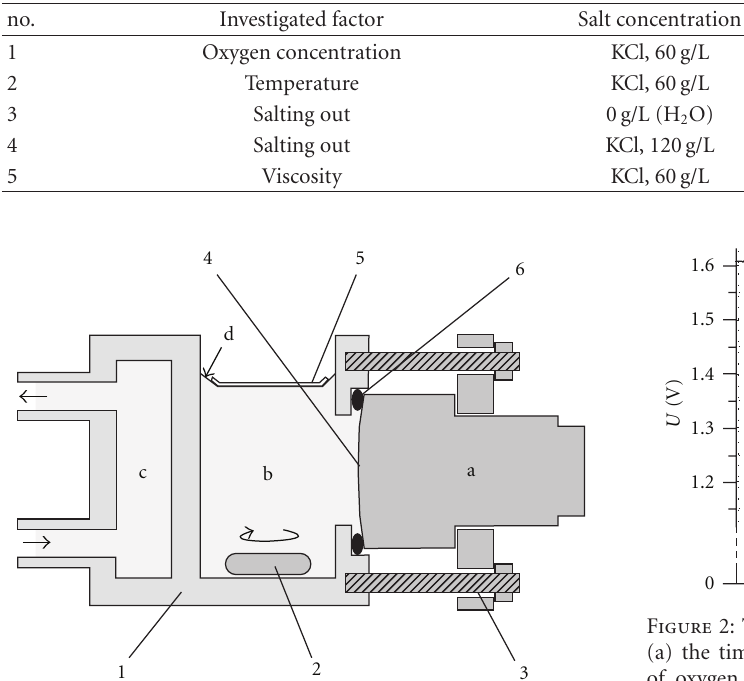
Table 1: Parameters of oxygen-free additives used in the study of the factors causing false oxygen consumption.